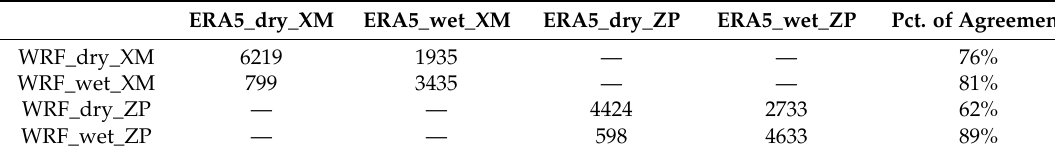
Table 4. Rainfall occurrence consistency between WRF and